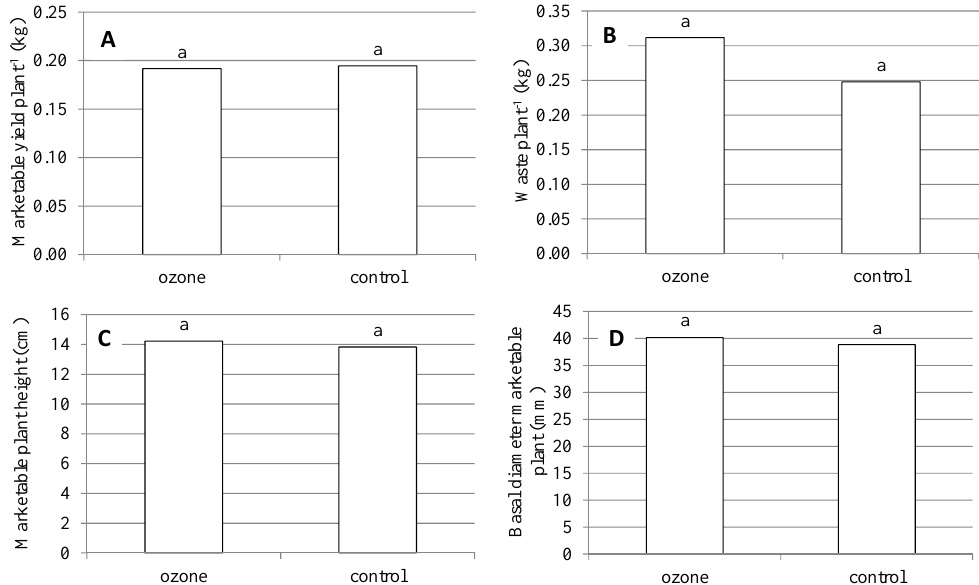
Figure 2. Influence of ozone treatment on production and morphological traits in Radicchio rosso di Treviso tardivo: marketable yield ( A ), waste production ( B ), marketable plant height ( C ) and plant basal diameter ( D ). Within each parameter, different letters indicate significant differences according to the Tukey’s Honest Significant Difference test at p < 0.05.